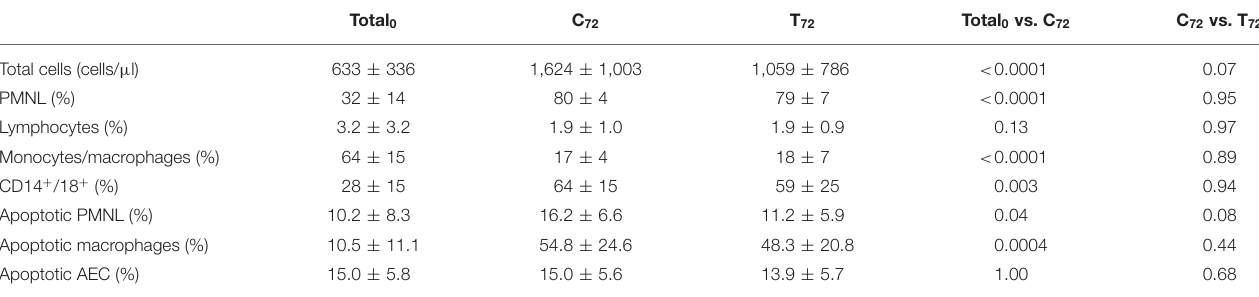
TABLE 7 | Cells in BALF and